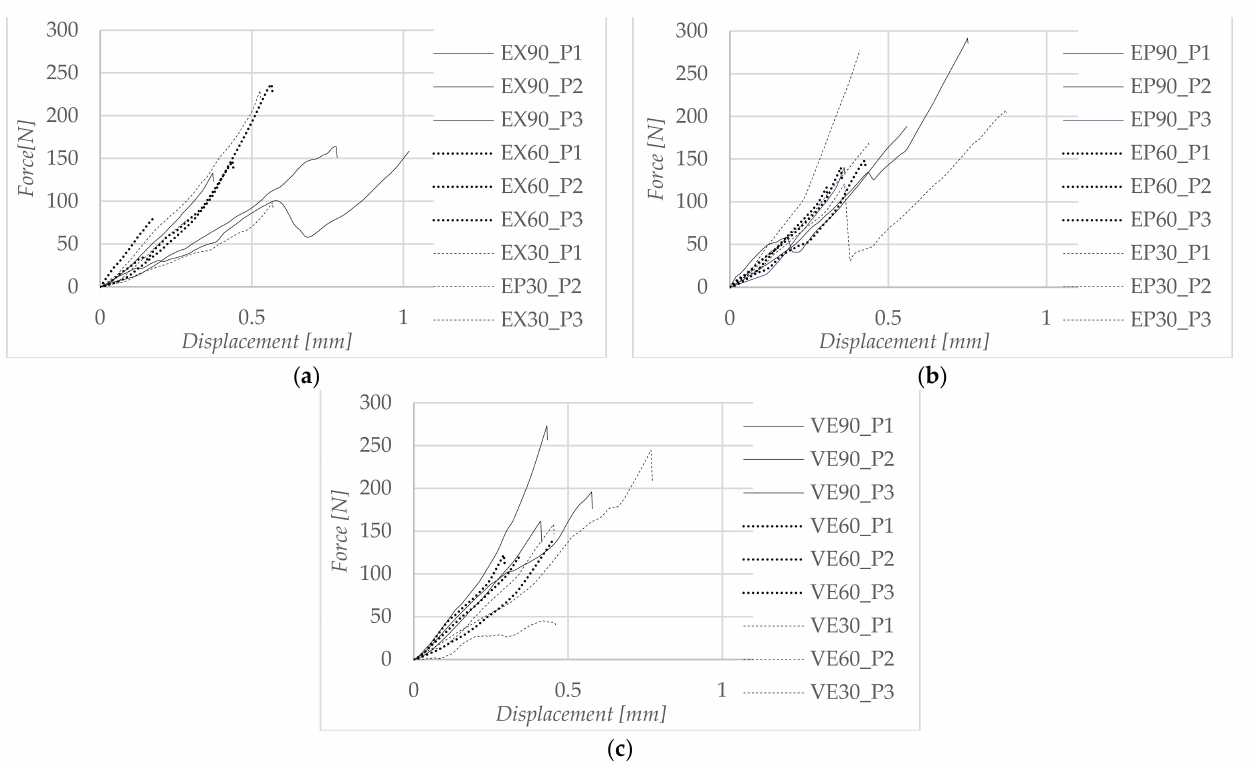
Figure 2. Force–displacement curves for some representative specimens. ( a ) Sample of EX: 9.5% HF for 30 s, 60 s and 90 s; ( b ) sample of EP: 9.5% HF for 30 s, 60 s and 90 s; ( c ) sample of VE: 9.5% HF for 30 s, 60 s and 90